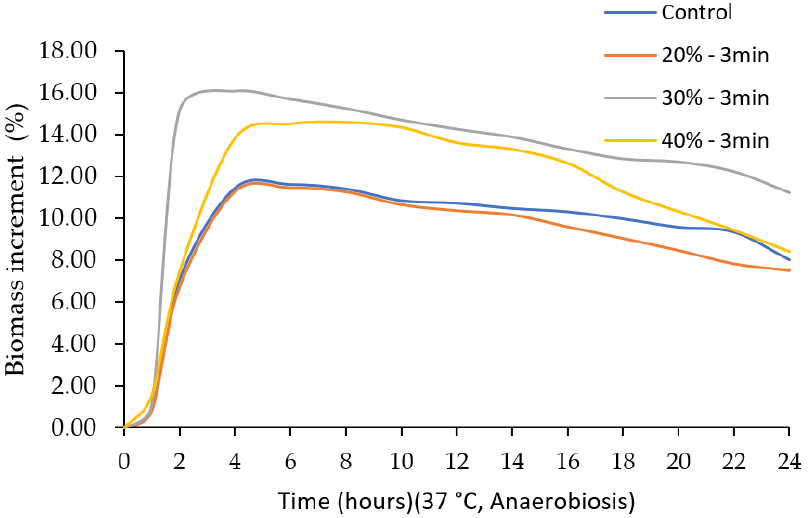
Figure 6. Effect of ultrasound amplitude on the pH kinetic of Lactobacillus acidophilus.